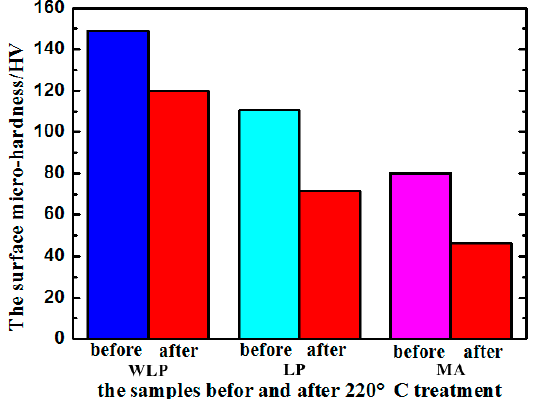
Figure 10. Surface micro ‐ hardness of samples before and after aging.